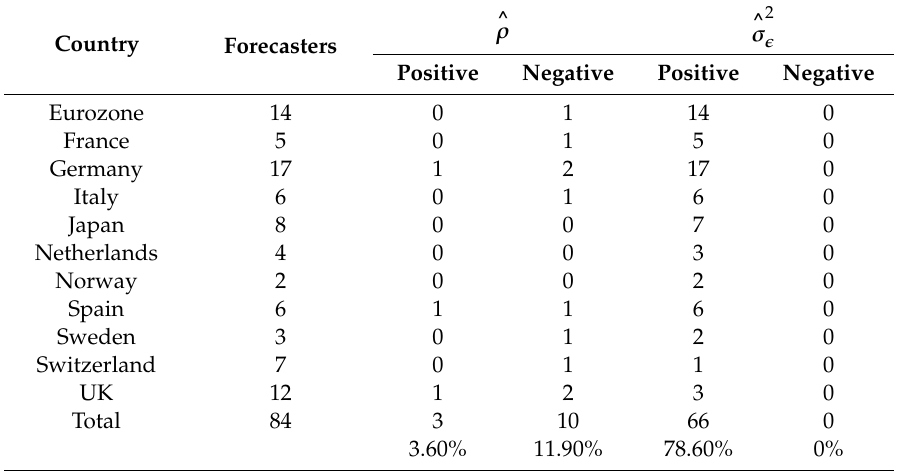
Table 4. Results for regression model (1) for other countries or regions, real GDP growth. The counts concern the number of cases with 10% significant estimation results.